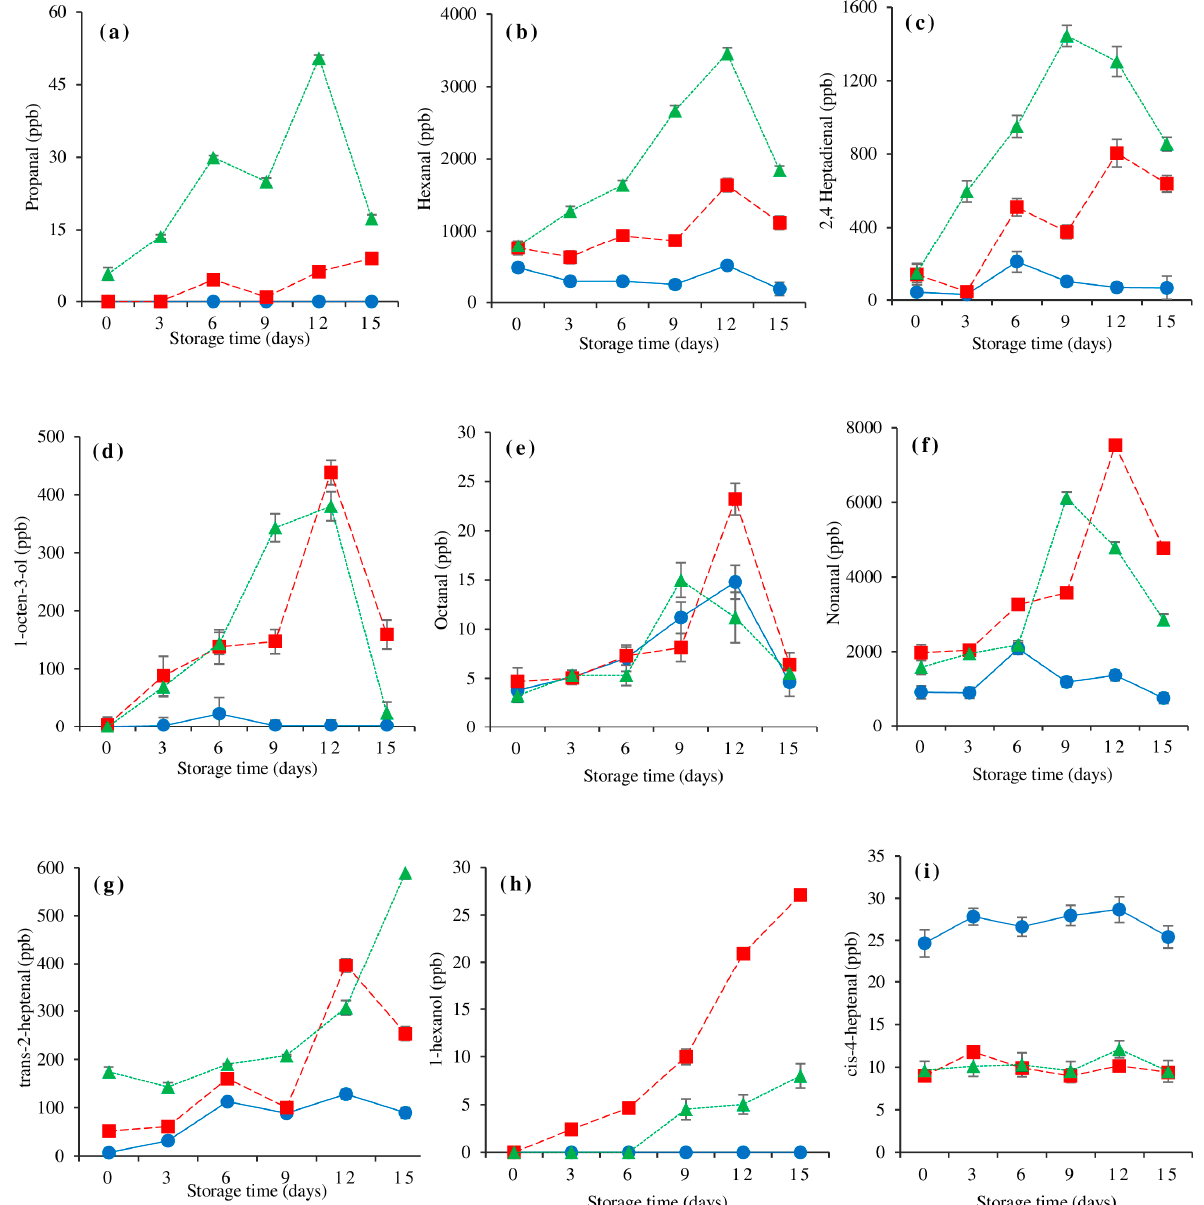
Figure 4. Changes in volatile lipid oxidation products, namely propanal ( a ), hexanal ( b ), 2,4 heptadienal ( c ), 1-octen-3-ol ( d ), octanal ( e ), nonanal ( f ), trans-2-heptenal ( g ), 1-hexanol ( h ) and cis-4-heptenal ( i ) of farmed hybrid catfish dorsal muscle ( ⎯ ● ⎯ ), lateral line (--- ■ ---), and ventral muscle ( … ▲ … ) during 15 days of refrigerated storage. The bars indicate standard deviation from triplicate determinations.